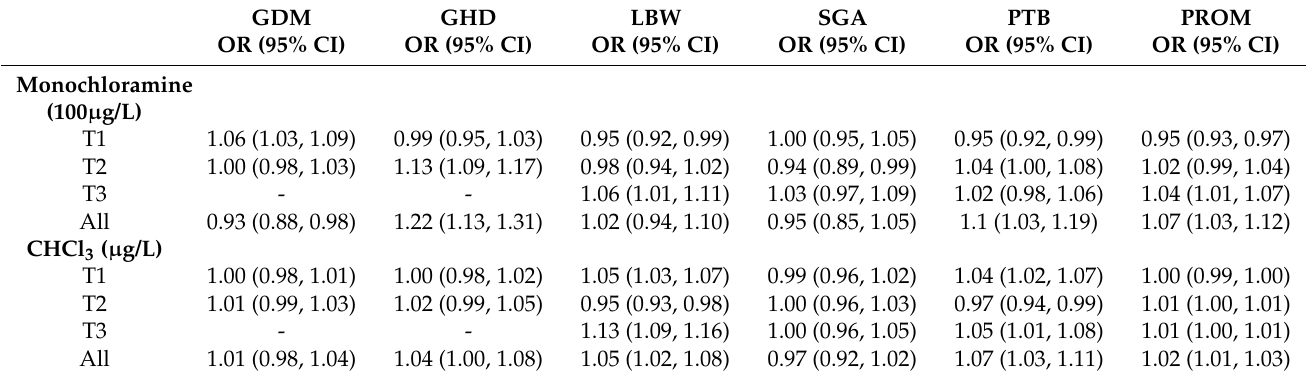
Table 3. Odds ratio of perinatal outcomes with increase of water pollutant (per unit). All analyses were adjusted for selected